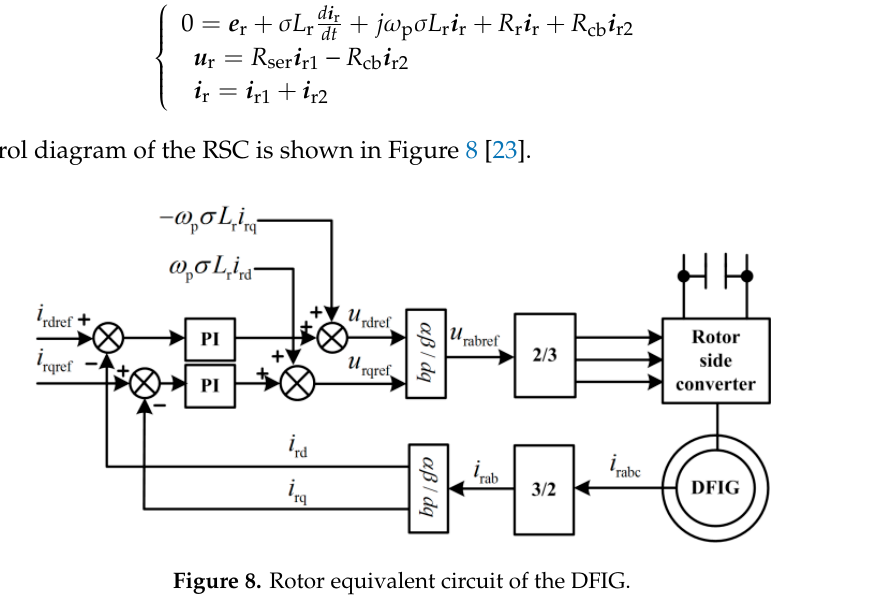
Figure 8. Rotor equivalent circuit of the DFIG.